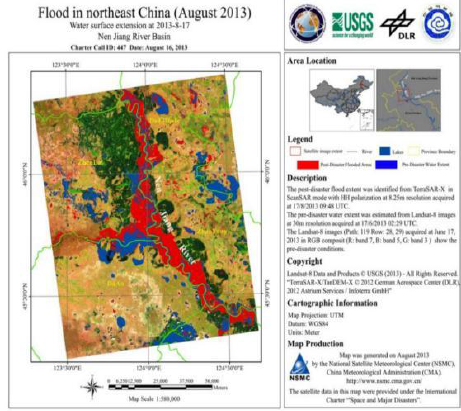
Figure 2: Water surface in Nen Jiang